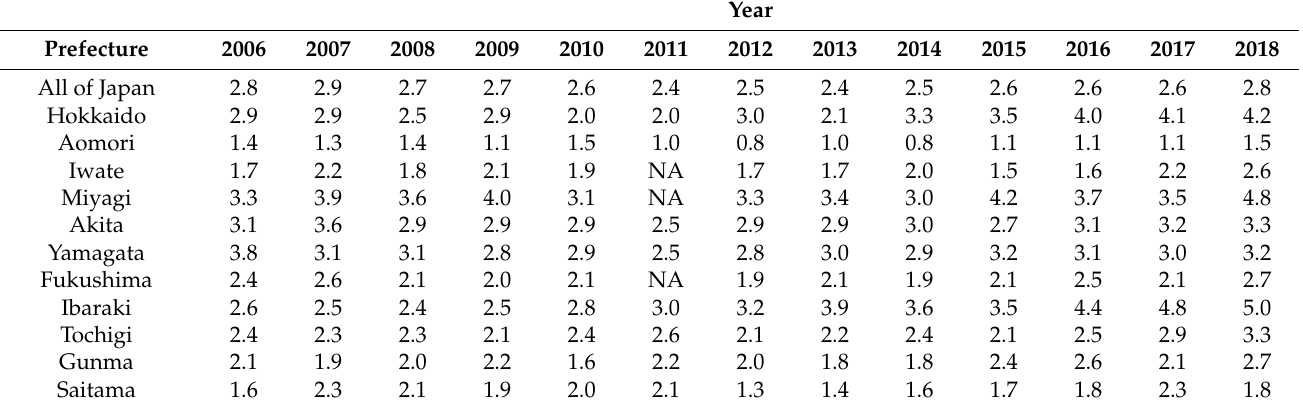
Table 2. Age-standardized prevalence of atopic dermatitis for each prefecture and year for girls.